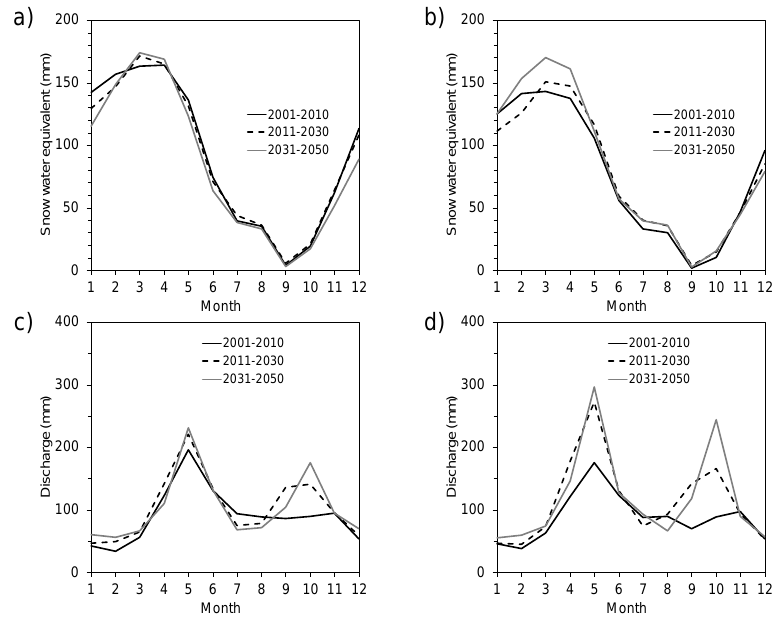
Figure 6. Mean monthly variables computed for periods 2001–2010, 2011–2030, and 2031–2050: ( a ) snow water equivalent driven by REMO, ( b ) snow water equivalent driven by RegCM3, ( c ) discharge driven by REMO, and ( d ) discharge driven by RegCM3.